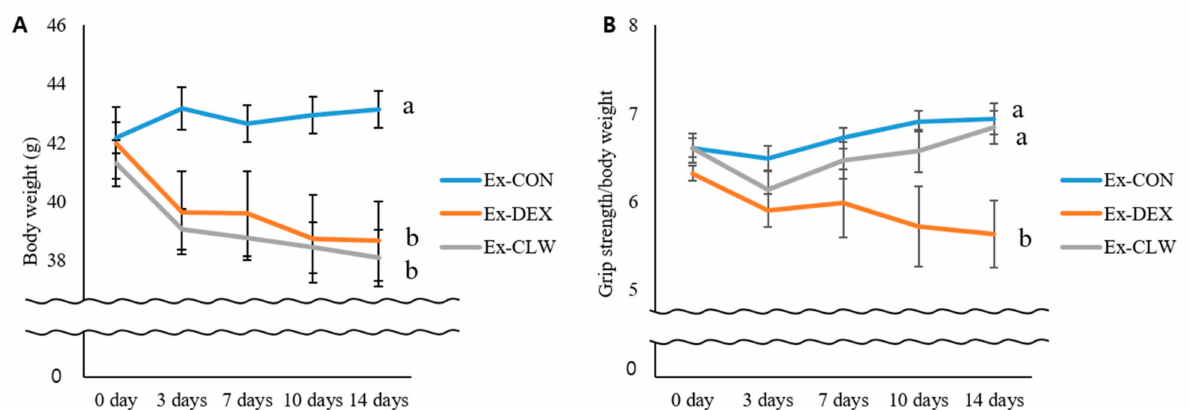
Figure 1. Effect of CLW on the body weight and grip strength in mice with DEX-induced muscle atrophy. Ex-CON, DW administration by gavage and saline IP injection group; Ex-DEX, DW administration by gavage and DEX (1 mg/body weight/day) IP injection group; Ex-CLW, CLW administration by gavage (1 g/body weight/day) and DEX IP injection group. ( A ) Body of the DEX-induced muscle after CLW supplementation in each mouse and ( B ) grip strength/body weight. Data are expressed as mean ± SE for eight mice in each group. Values with different superscripts indicate a significant difference among groups based on Duncan’s multiple range test ( p < 0.05). CLW may help prevent the decrease in grip strength due to muscle